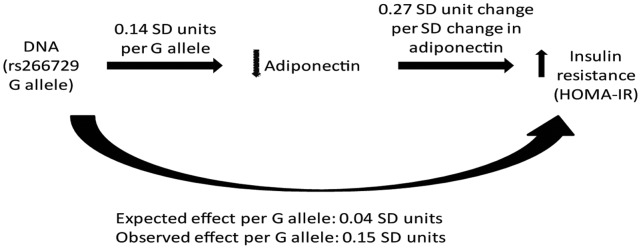
Pictorial summary of the effect of the rs266729 polymorphism on HOMA-IR.